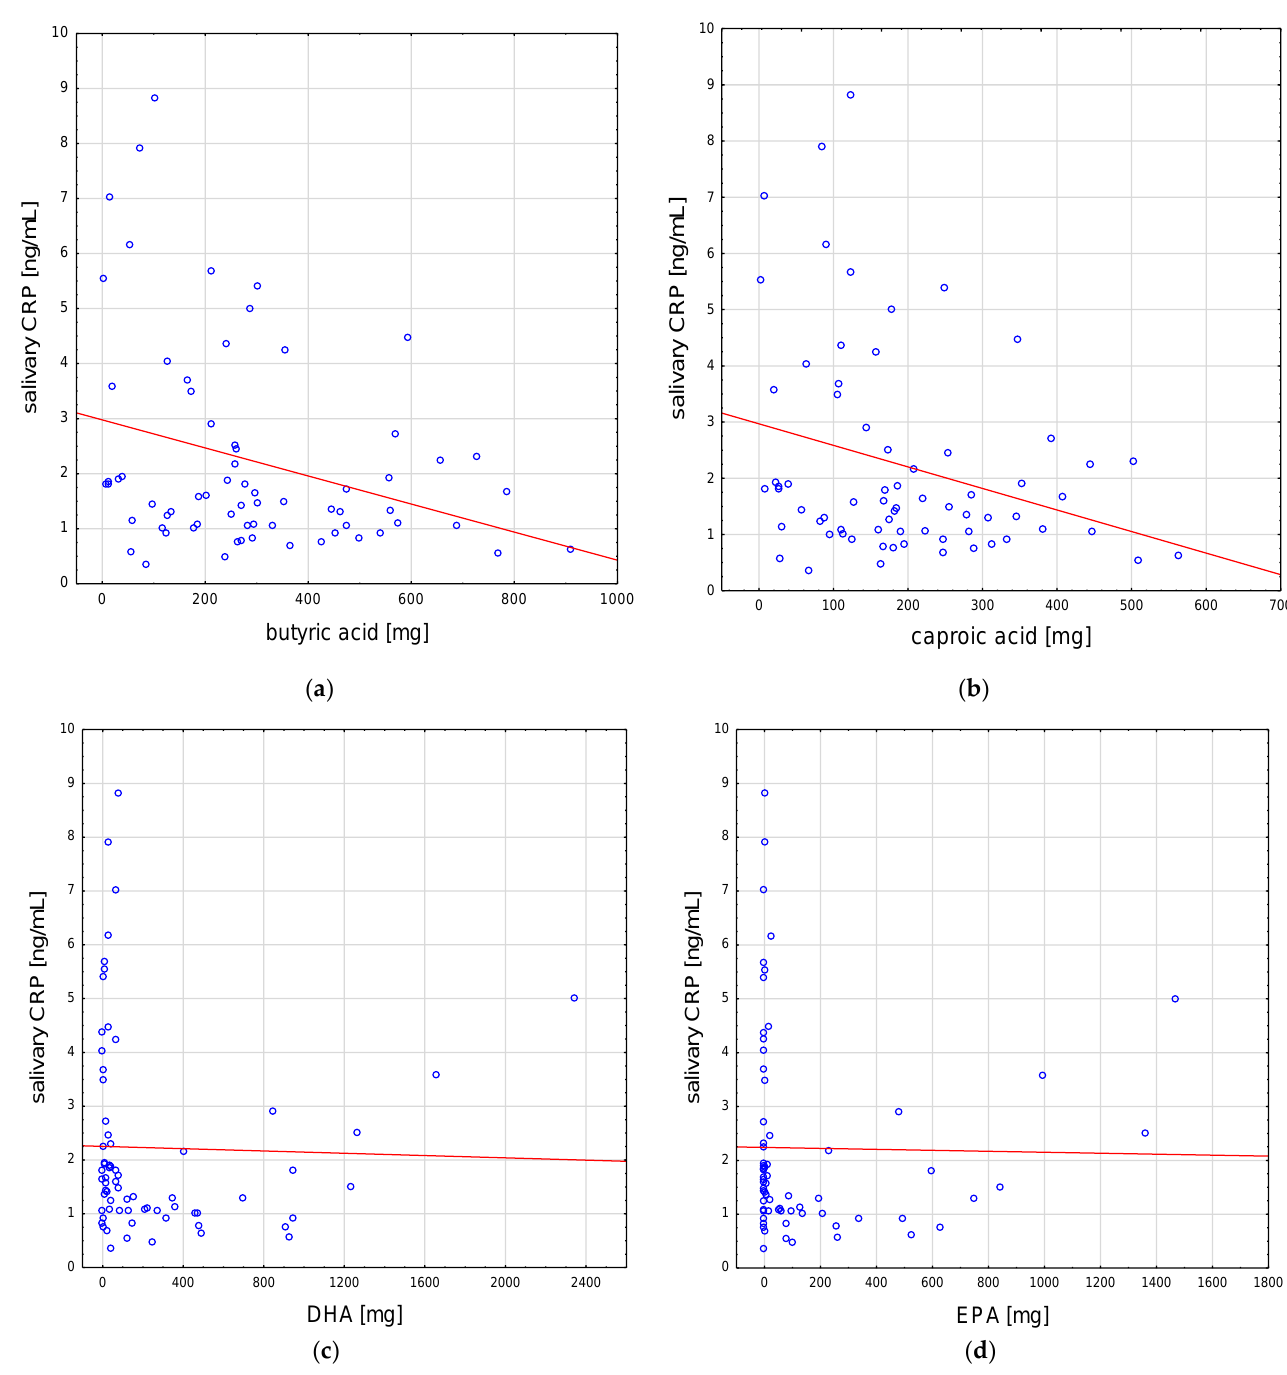
Figure 3. Selected correlations of salivary C-reactive protein with the short-chain fatty acids: ( a ) butyric acid and ( b ) caproic acid; and of salivary C-reactive protein with the PUFA: ( c ) DHA and ( d ) EPA in the whole study group. DPA, docosapentaenoic acid; EPA, eicosapentaenoic acid.